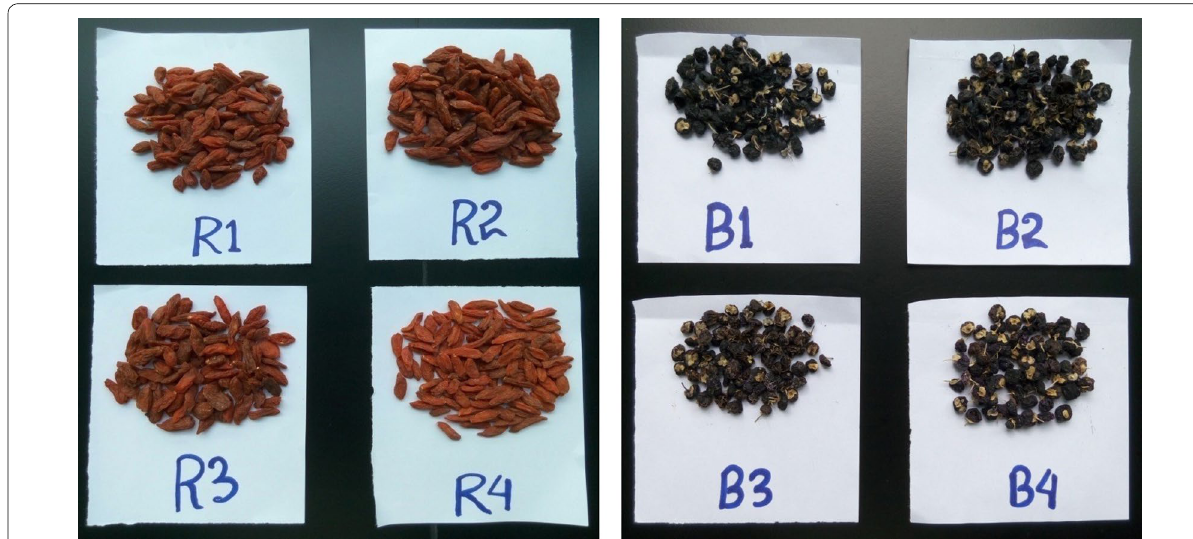
Fig. 1 Pictures of red goji berry ( L. barbarum ) and black goji berry ( L. ruthenicum )